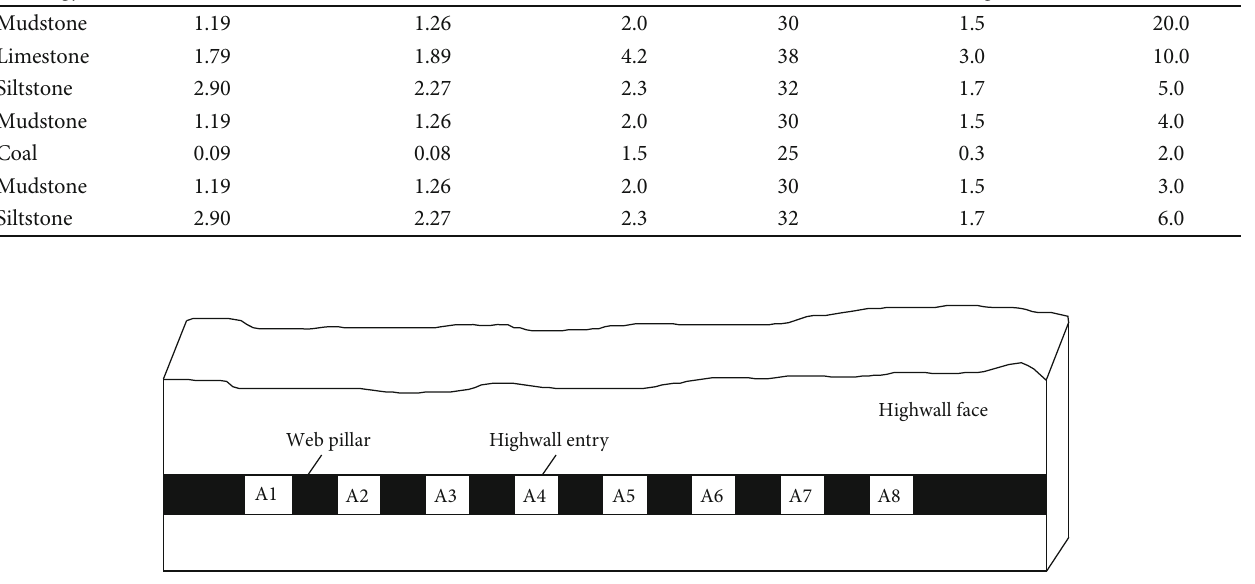
Figure 4: Typical geometry of highwall mining pane.